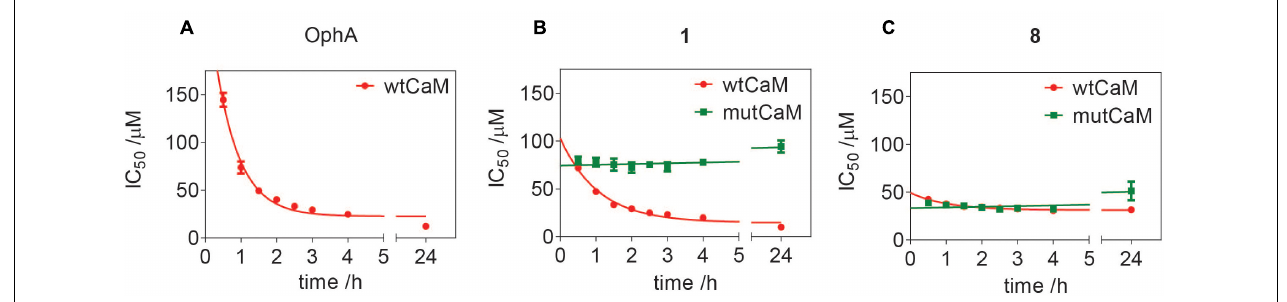
FIGURE 5 | Assessment of lysine-dependent CaM-binding activity of OphA, formyl aminobenzazulenone 1 , and aminobenzazulenone 8 . Time course of lysine-dependent CaM-binding activity of OphA (A) , compound 1 (B) , and compound 8 (C) as measured in the fluorescence polarization assay using F-CaMKII peptide as the fluorescent probe. OphA displayed negligible binding with mutCaM compared to wtCaM; hence, no IC 50 values could be derived ( Supplementary Figures 5A,B ).